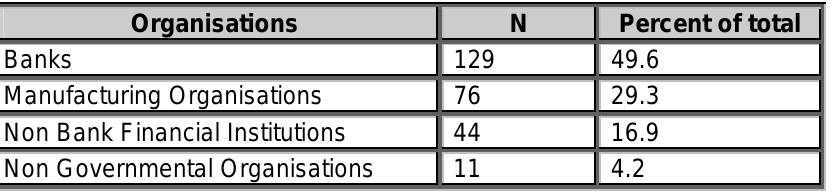
Table 2: Employee sample Organisations